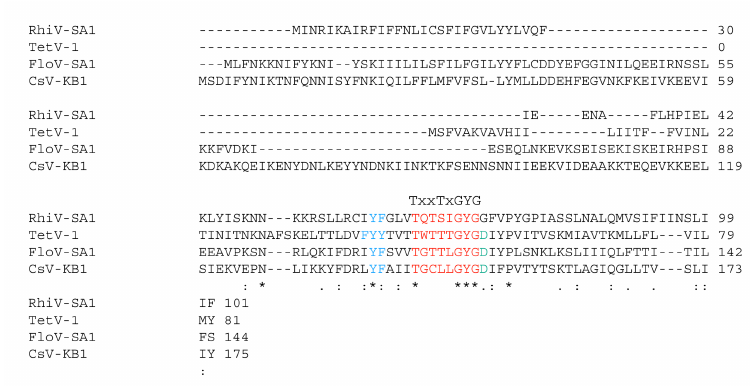
Figure 1. Multiple sequence alignment of putative K + channels from viruses RhiV-SA1, TetV-1, FloV-SA-1, and CsV-KB1. The consensus sequence of K + channels (on top) is highlighted in red. The residues in blue indicate functionally important aromatic amino acids in K + channels upstream of the consensus motif. In the alignment, identical amino acids are indicated by “*” and conserved (amino acids with similar characteristics) and semi-conserved (amino acids having similar shape) amino acids are indicated by “:” and “.”, respectively.